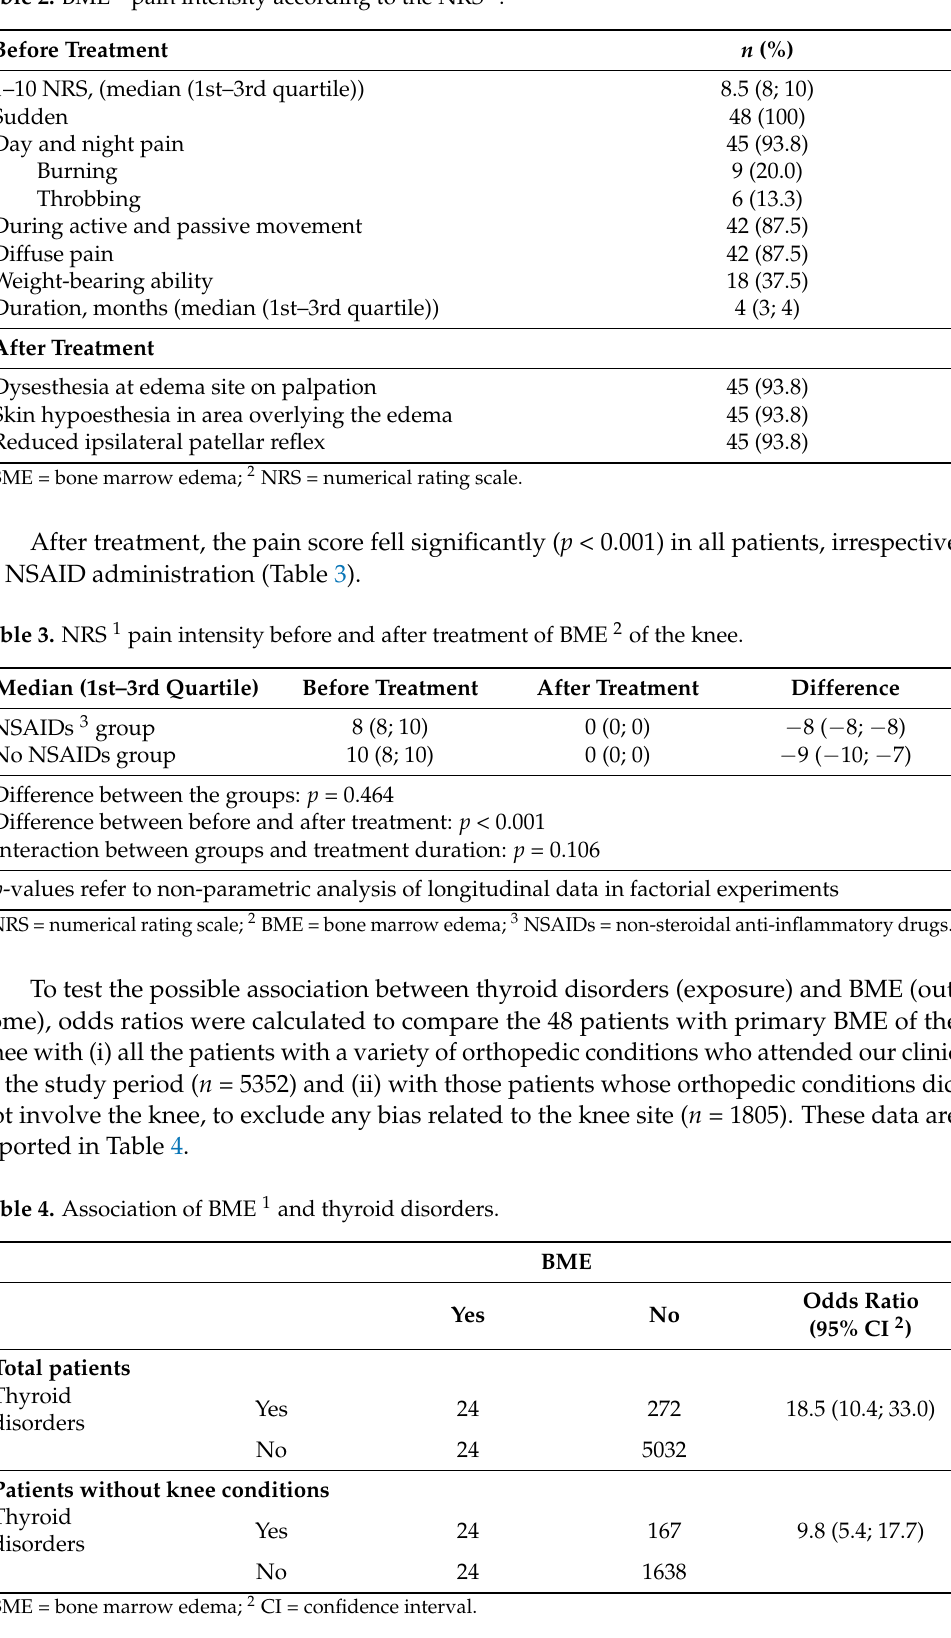
Table 2. BME 1 pain intensity according to the NRS 2 .